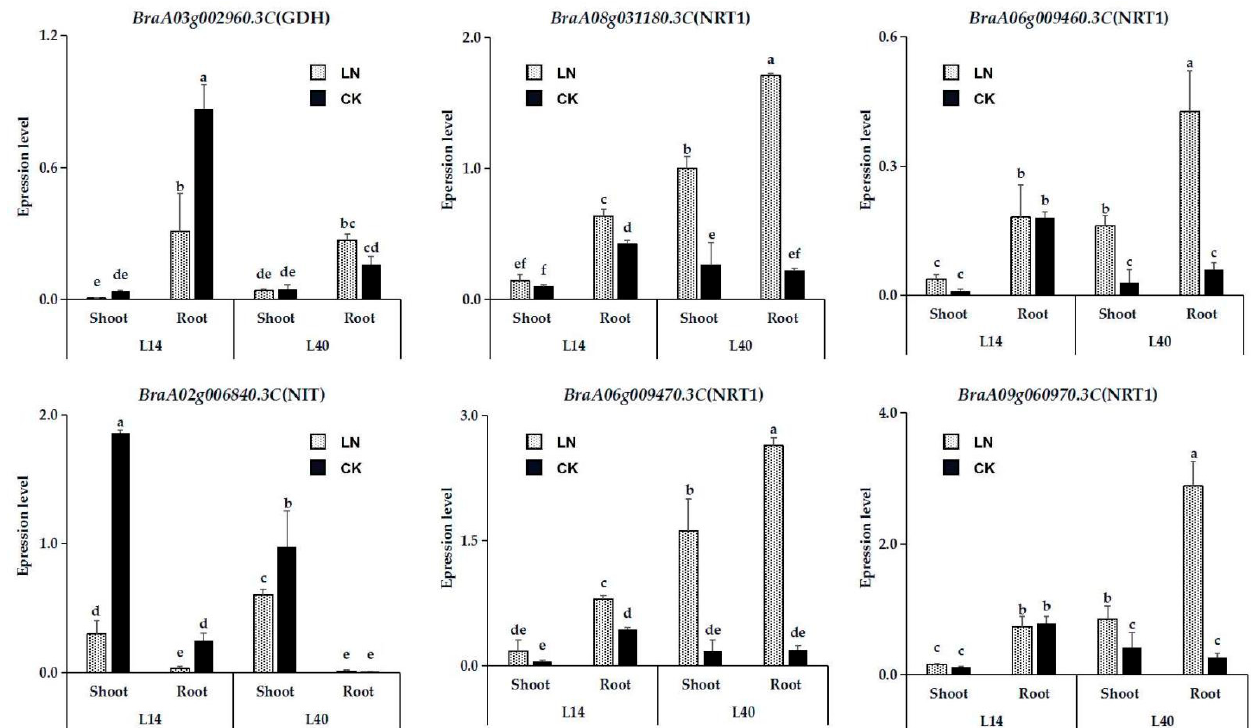
Figure 8. qRT-PCR validation of DEGs from high-throughput sequencing analyses. Relative expres- sion levels were calculated as the reference gene using the formula 2 −Δ Ct . The value indicates the means of three biological replicates ± SE. The letters “LN” and “CK” indicate whether the N content was low or normal. Means with different letters are significantly different according to the Duncan test at p < 0.05.